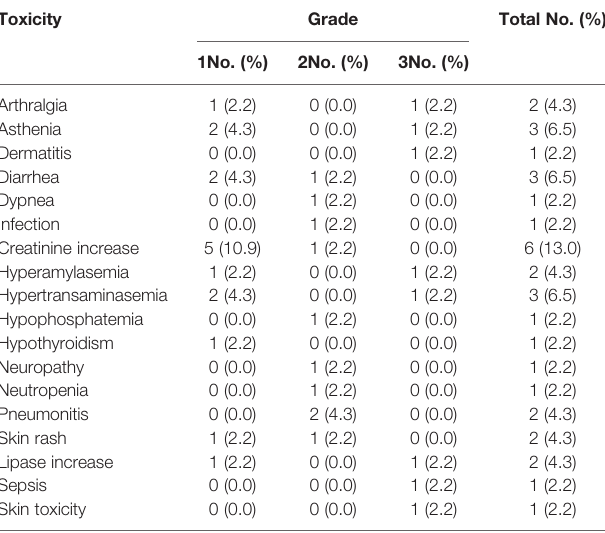
TABLE 5 | Toxicities recorded in both ICI and ICI+BTT treatments.